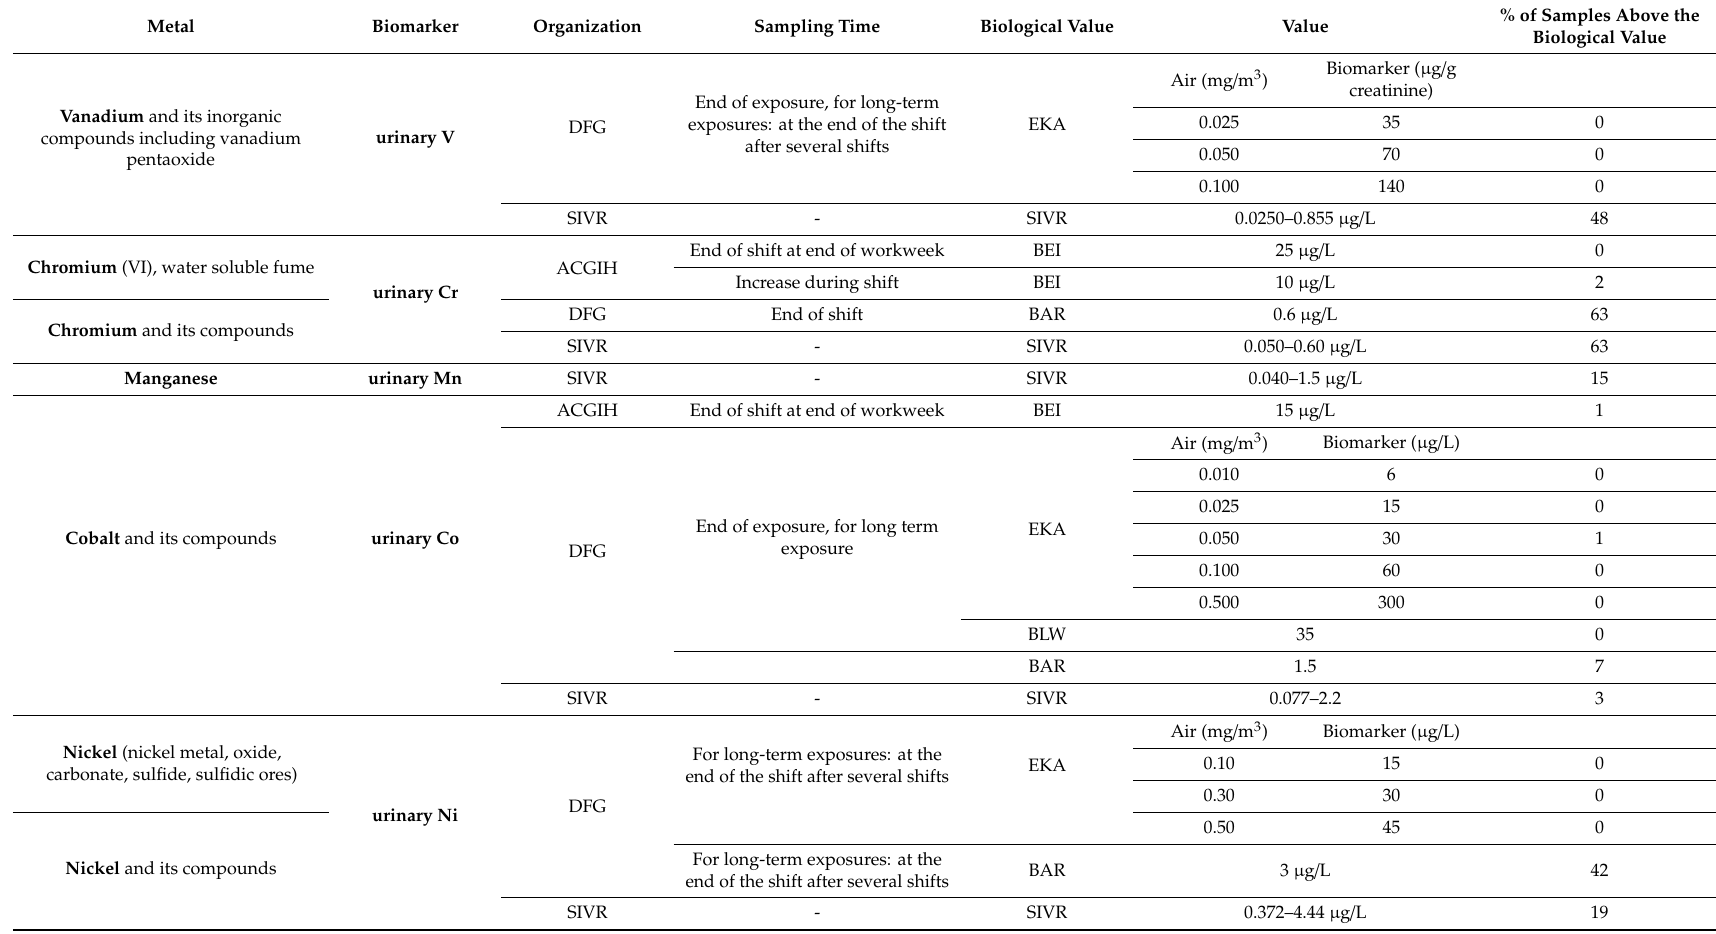
Table 3. Occupational limit values and reference values for the general population for urinary metals proposed by di ff erent organizations. The percentage of samples of study workers exceeding the biological values is